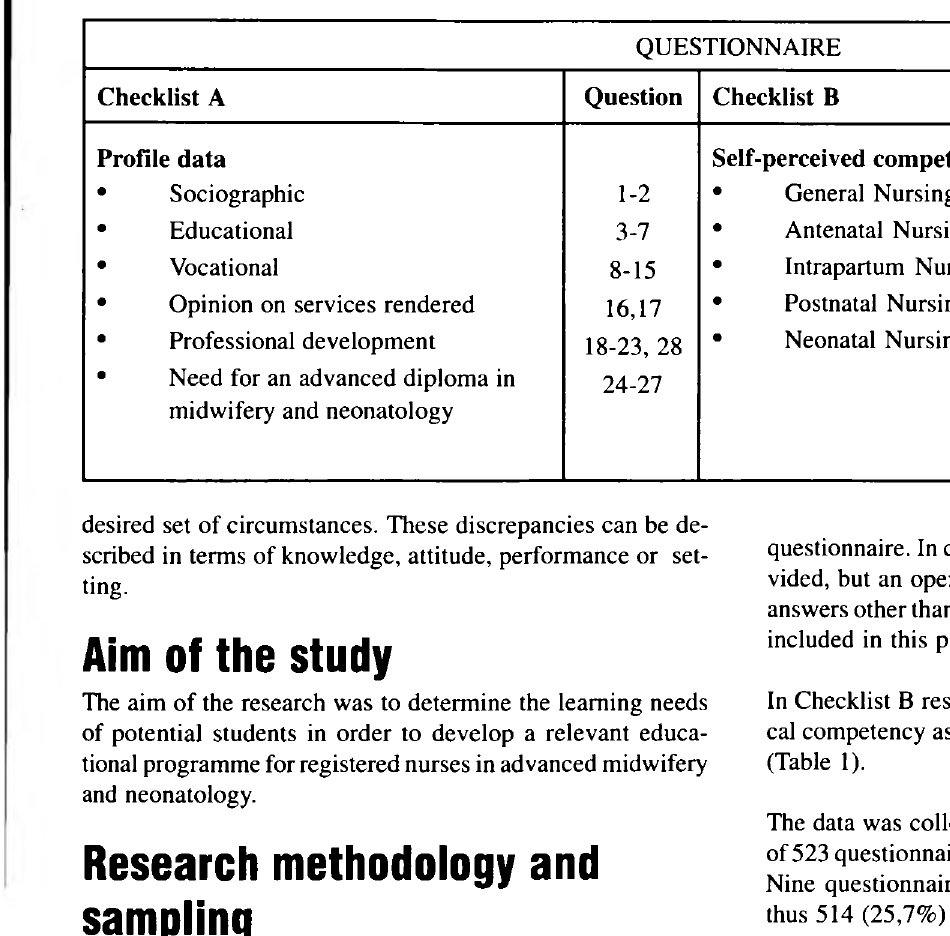
TABLE 1 : Categories of data covered in the